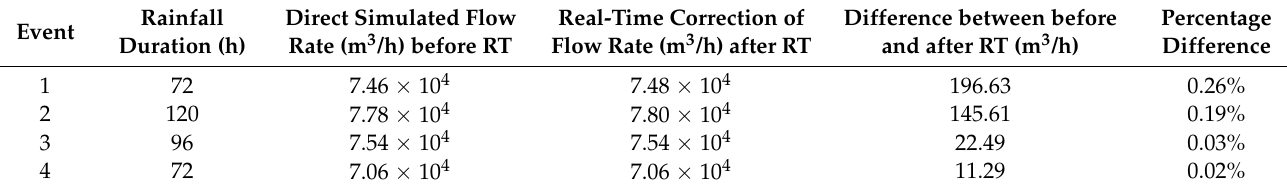
Table 3. Comparison of calculated flow rate before and after RT correction.